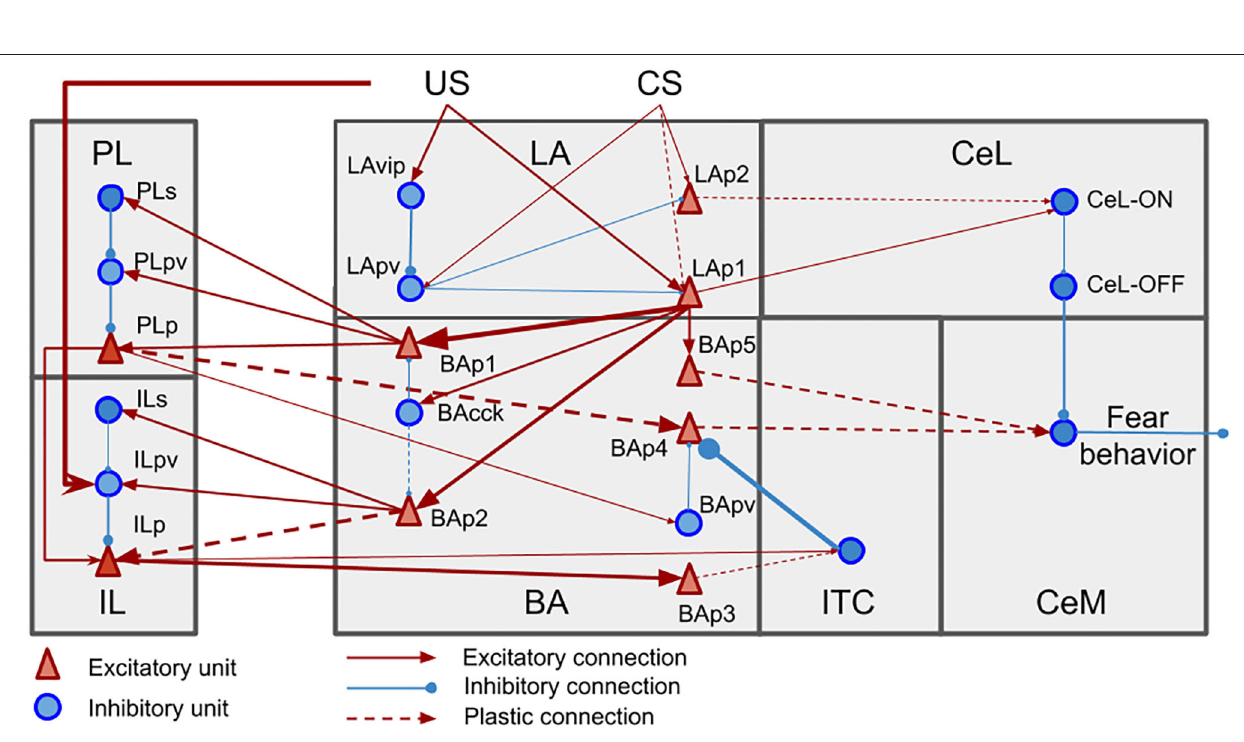
Frontiers in Systems Neuroscience | www.frontiersin.org